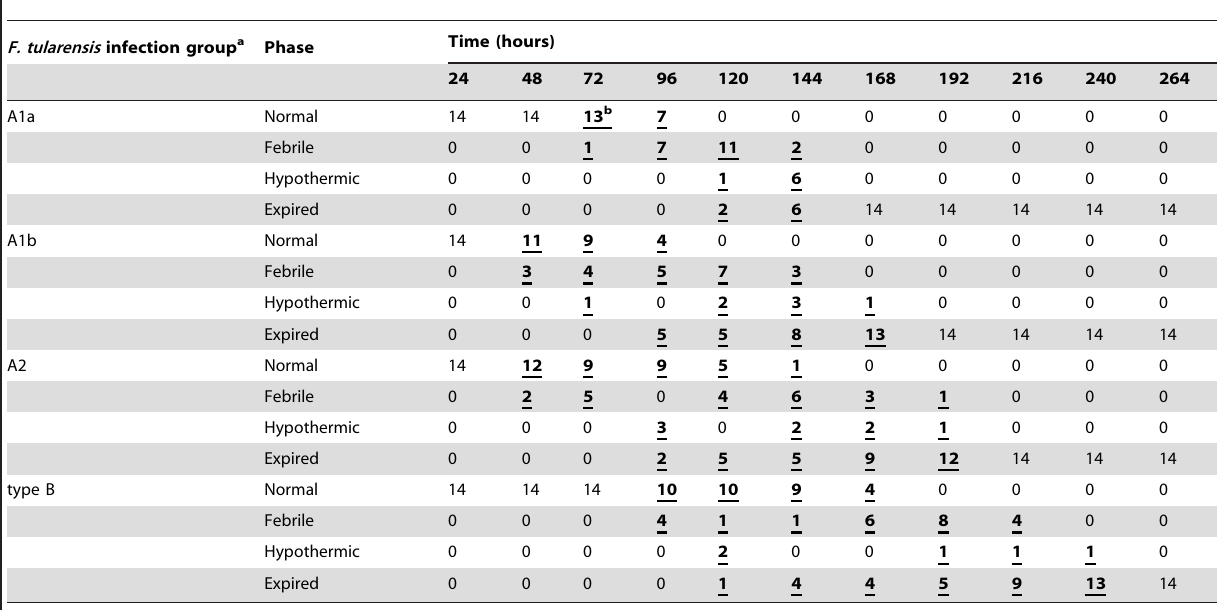
Table 2. Number of mice in each phase over